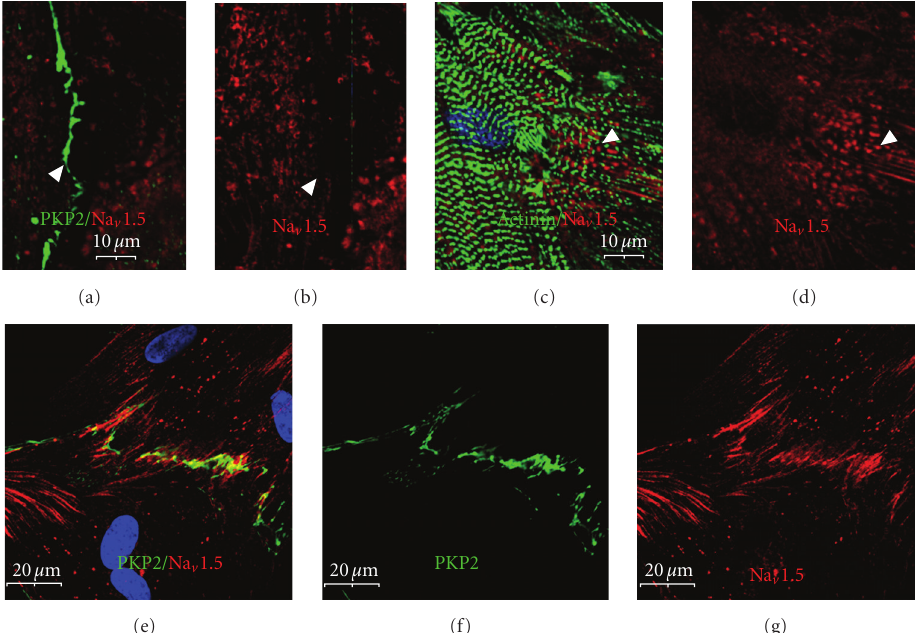
Figure 9: The α subunit of the voltage-gated sodium channel is incorporated significantly later into the newly-formed intercalated disks. ARCs at 5 (a)–(d) and 13 (e)–(g) days post plating were immunolabeled for Na v 1.5 (red: (a)–(e) and (g)) and PKP2 (green: a, e, f) or α - actinin (green: (c)). (a, b) At the 5-day timepoint, there is no detectable localization of Na v 1.5 even to mature cell adhesion sites (arrowhead). (c, d) Instead, Na v 1.5 appears to be more closely associated with assembling myofibrils (arrowhead). Note the linear arrays of Na v 1.5 immunolabeling between α -actinin-labeled myofibrils. (e)–(g) By 13 days post plating, the channel has localized to the new intercalated disk, significantly after the other components. Scale bars are 10 μ m (a)–(d) and 20 μ m